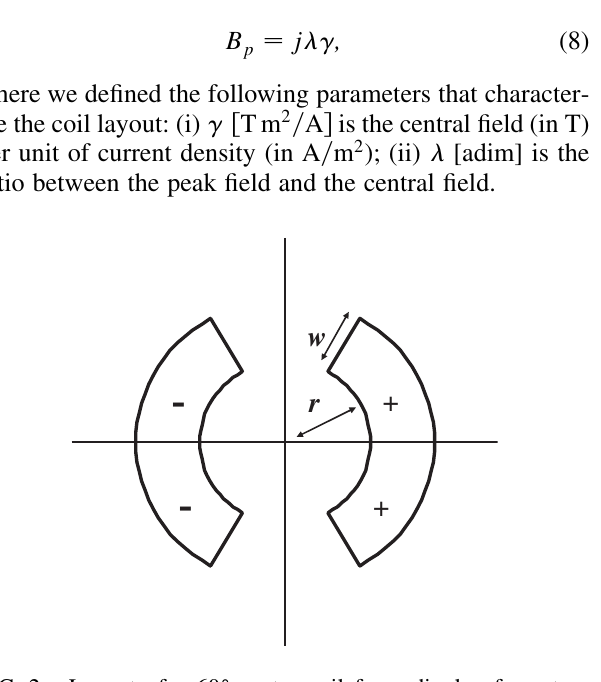
FIG. 3. Example of critical surface, loadline, critical current, and critical peak field for the LHC main dipole (Nb-Ti at 1.9